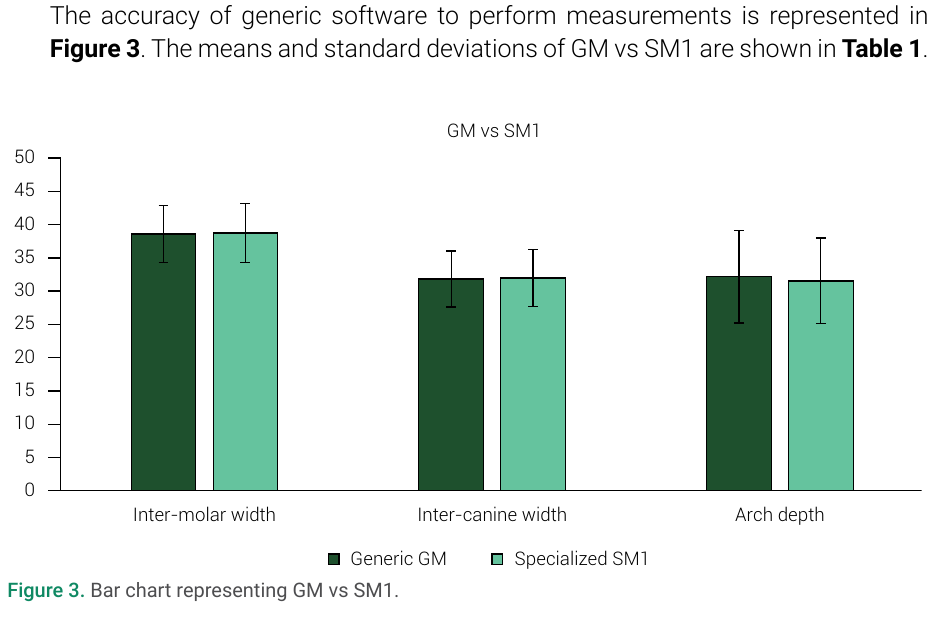
Figure 3. Bar chart representing GM vs SM1.